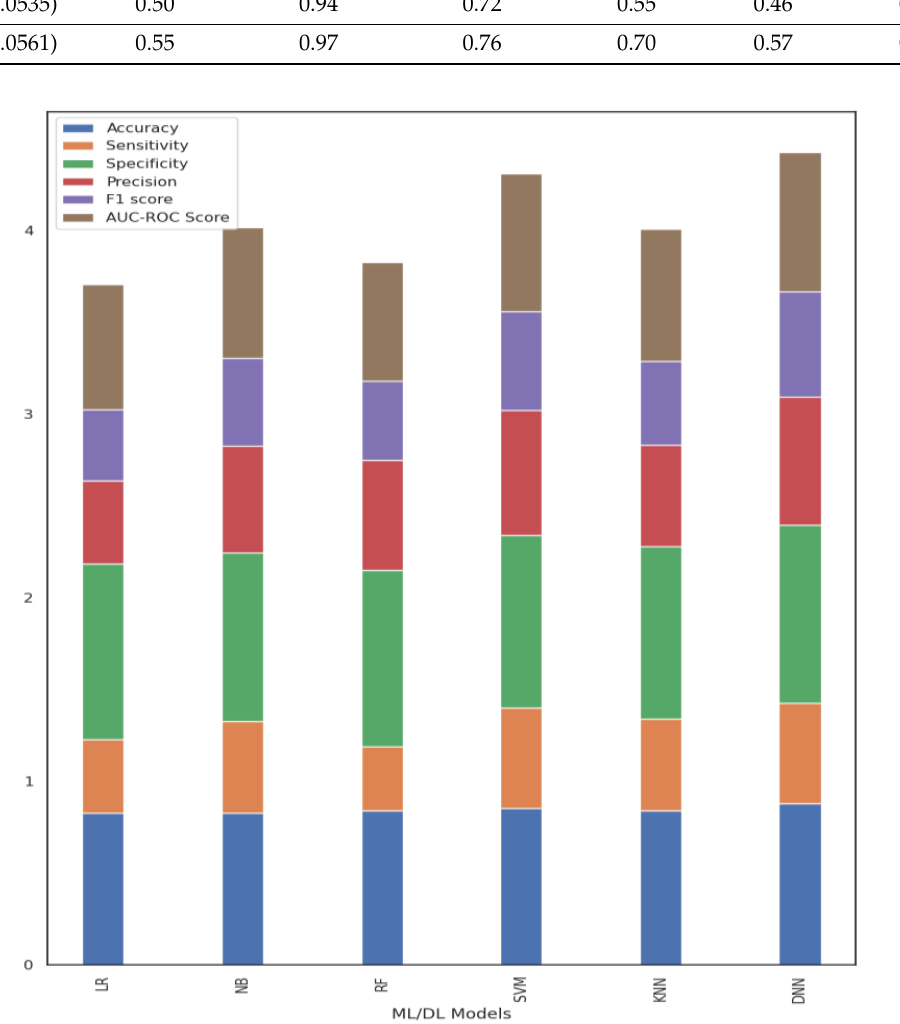
Figure 16. The pictorial representation of comparative performance estimation using different ML/DL models based on the stratified five-fold cross-validation.